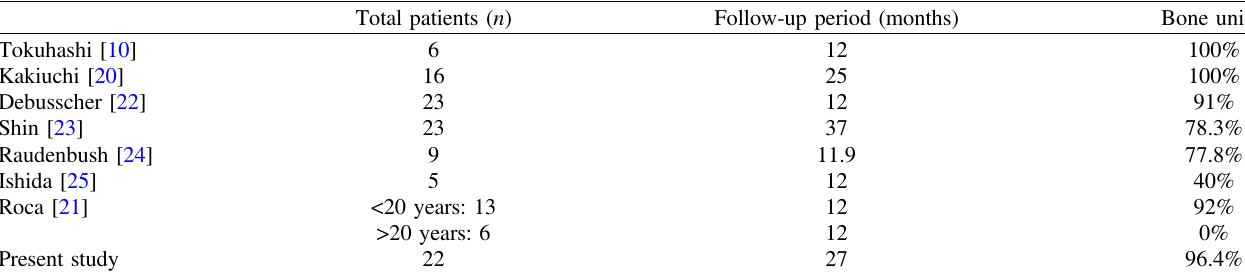
Table 3. Bone union at the pars defect in different studies performing the technique. Total patients ( n ) Follow-up period